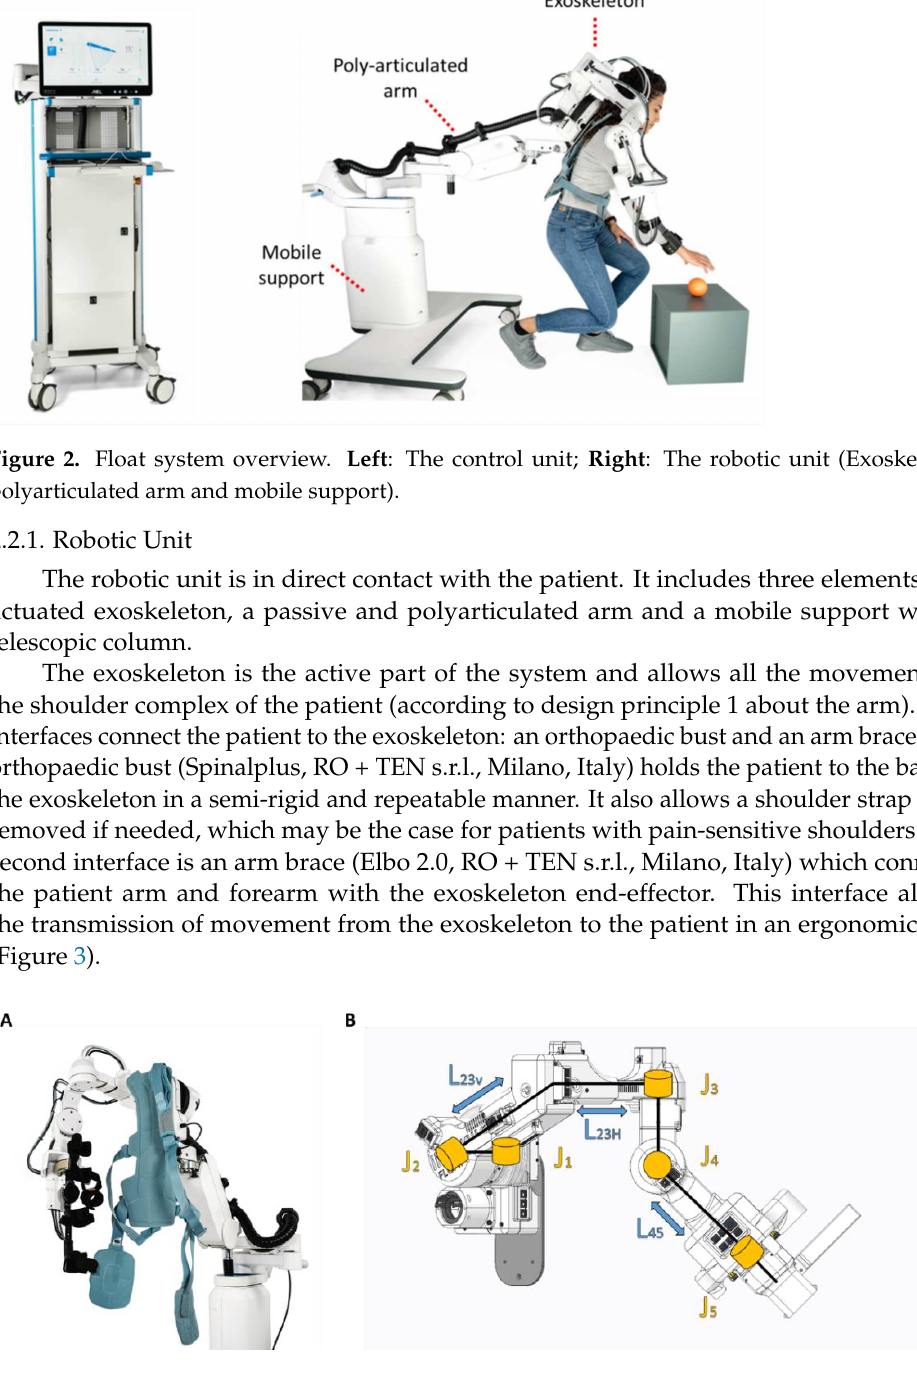
Figure 3. Actuated exoskeleton kinematic structure of the Float system. ( A ), picture of the Float actuated exoskeleton with the orthopaedic bust and the arm brace and ( B ) the kinematic structure of the exoskeleton with the adjustable links.